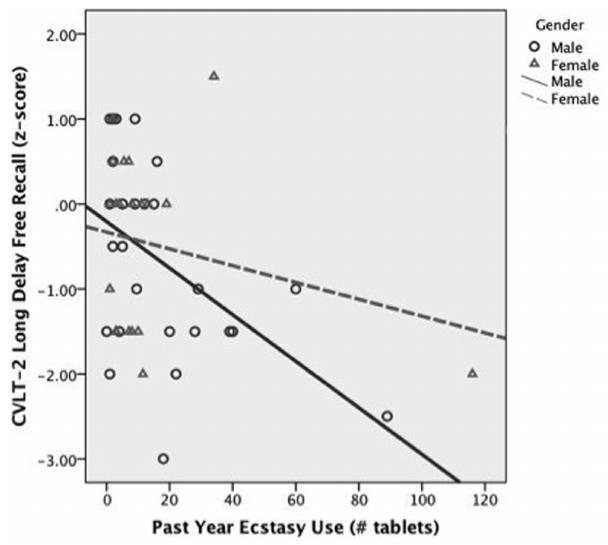
Fig. 1. Bivariate Relationship between CVLT-2 Retention z-score and Past Year Ecstasy Use According to Gender.